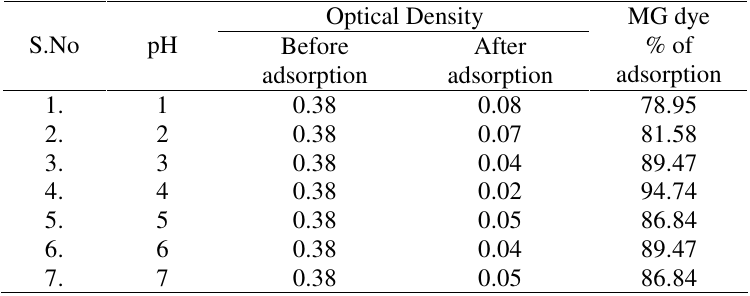
Table 4 . Effect of pH on removal of MG dye (contact time: 180